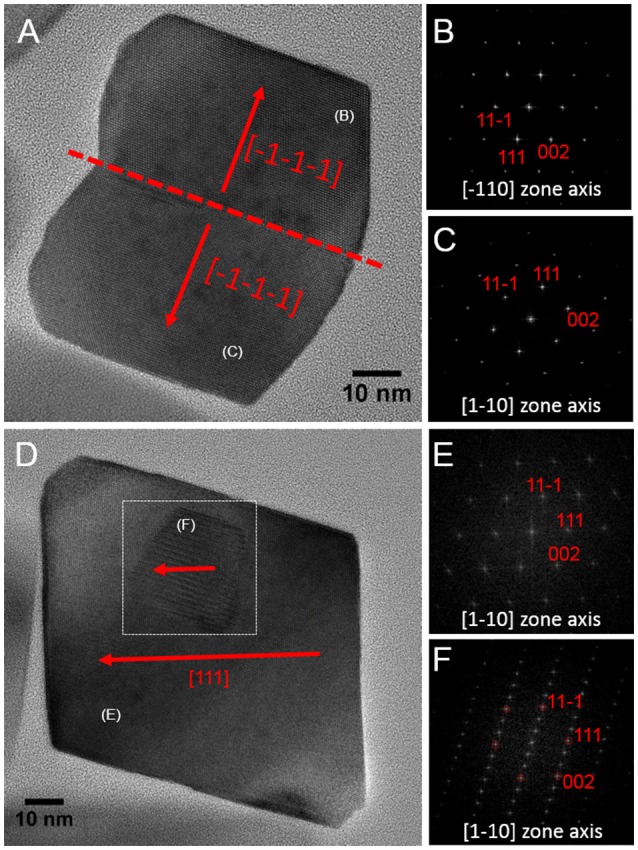
HRTEM images of defected crystals of SHHC-1 magnetosomes. (A) Bright Field HRTEM image of one twin magnetosome crystal with a straight contact (–1–1–1) plane (A); corresponding indexed FFT patterns from the upper (B) and lower (C) parts of the crystal shown in (A). (D) HRTEM of one defected magnetosome containing a stacking fault in it (indicated by white dashed square); corresponding indexed FFT patterns from the normal (E) and the defected (F) areas.